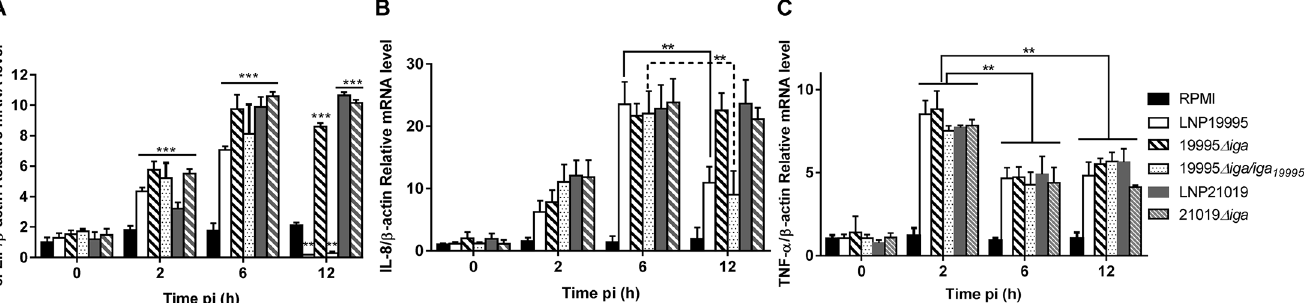
Fig 7. ST-11 IgA protease-mediated nuclear cleavage of p65/RelA alters selectively expression of NF- κ B responsive genes. Hec-1-B cells were infected for the indicated periods, After infection of Hec-1-B cells with the indicated strains and periods, mRNA levels of c-FLIP (A), IL-8 (B) and TNF- α (C) were evaluated by real-time PCR. Target mRNA expression was normalized to β -actin mRNA. *** , P < 0.001 ; ** , P < 0.01